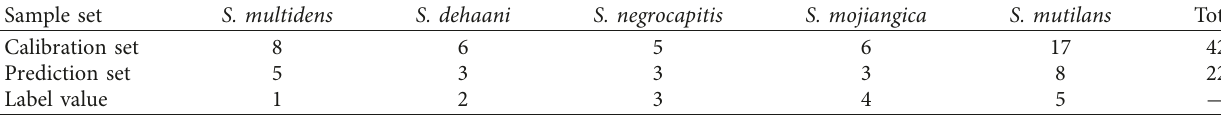
Table 2: Classified information of the qualitative model of medicinal centipedes.